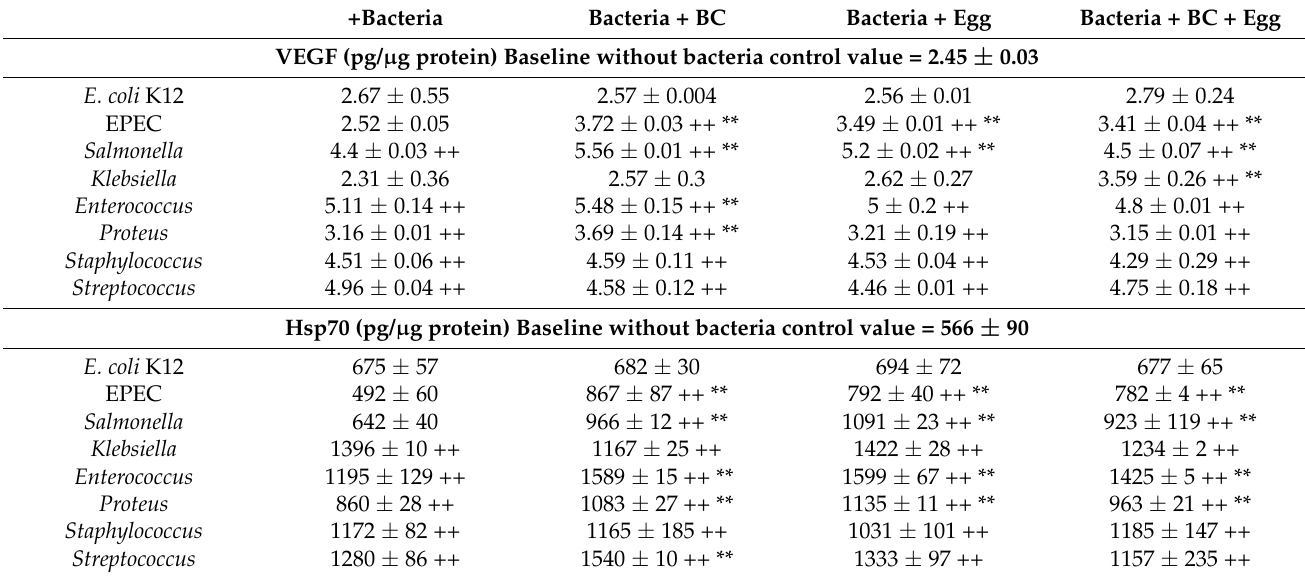
Table 3. Effect of BC alone, egg, or the combination on damaging effect of bacterial strains on VEGF and Hsp70. +Bacteria Bacteria + BC Bacteria + Egg Bacteria + BC +